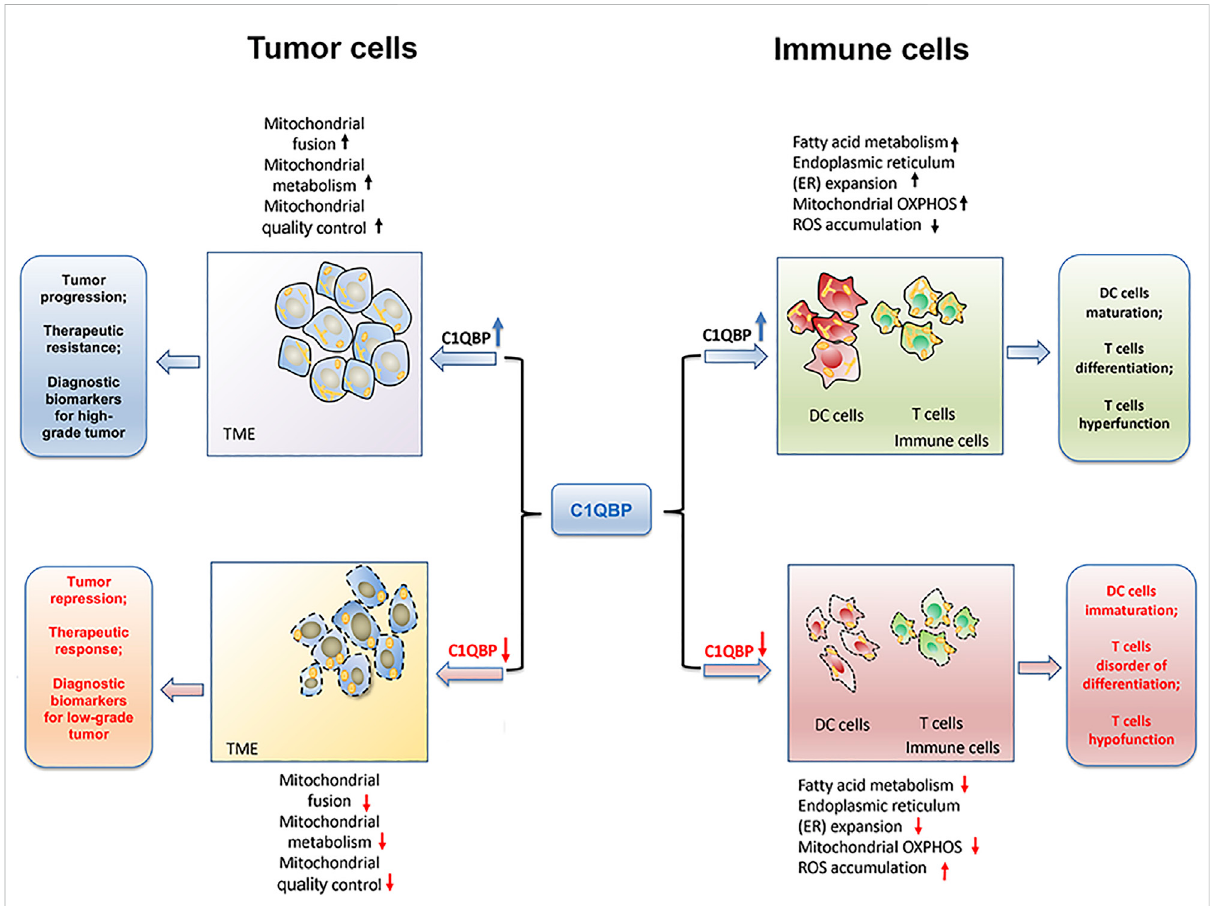
FIGURE 1 C1QBP regulation of mitochondrial plasticity to impact tumor progression and antitumor immunity. C1QBP regulates mitochondrial fusion, mitochondrial OXPHOS, and mitochondrial quality control to impact tumor malignant progression and therapeutic response. On the other hand, C1QBP also changes fatty acid metabolism, ERexpansion, and ROS accumulation, thus modulating DCs ’ maturation as well as T cells ’ differentiation and their effector